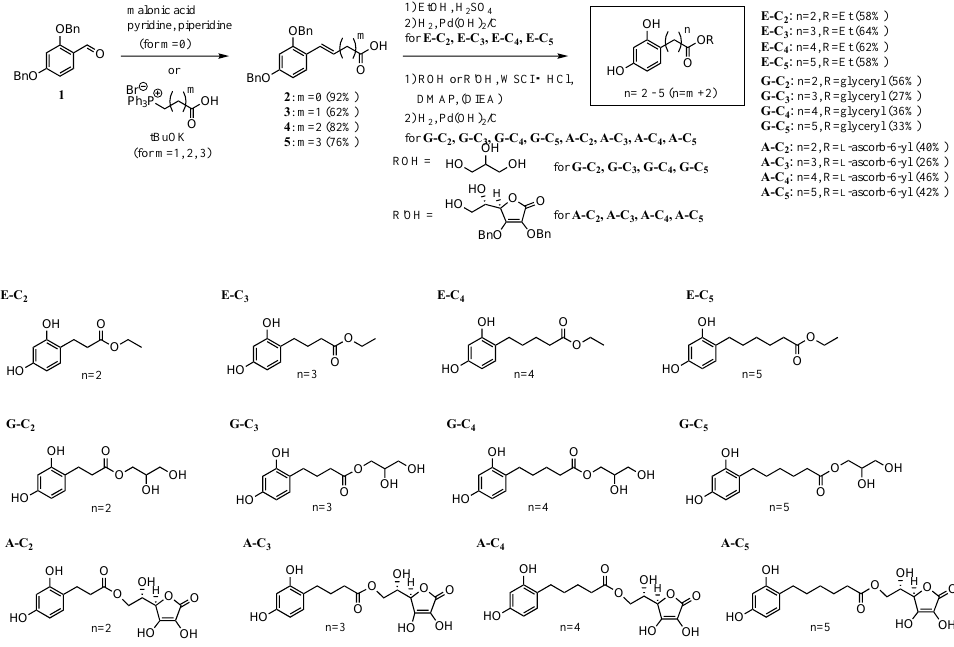
Figure 1. Synthetic pathway and structures of the resorcinol derivatives . Table 1. Sample name, molecular weight and cLogP of the resorcinol derivatives.